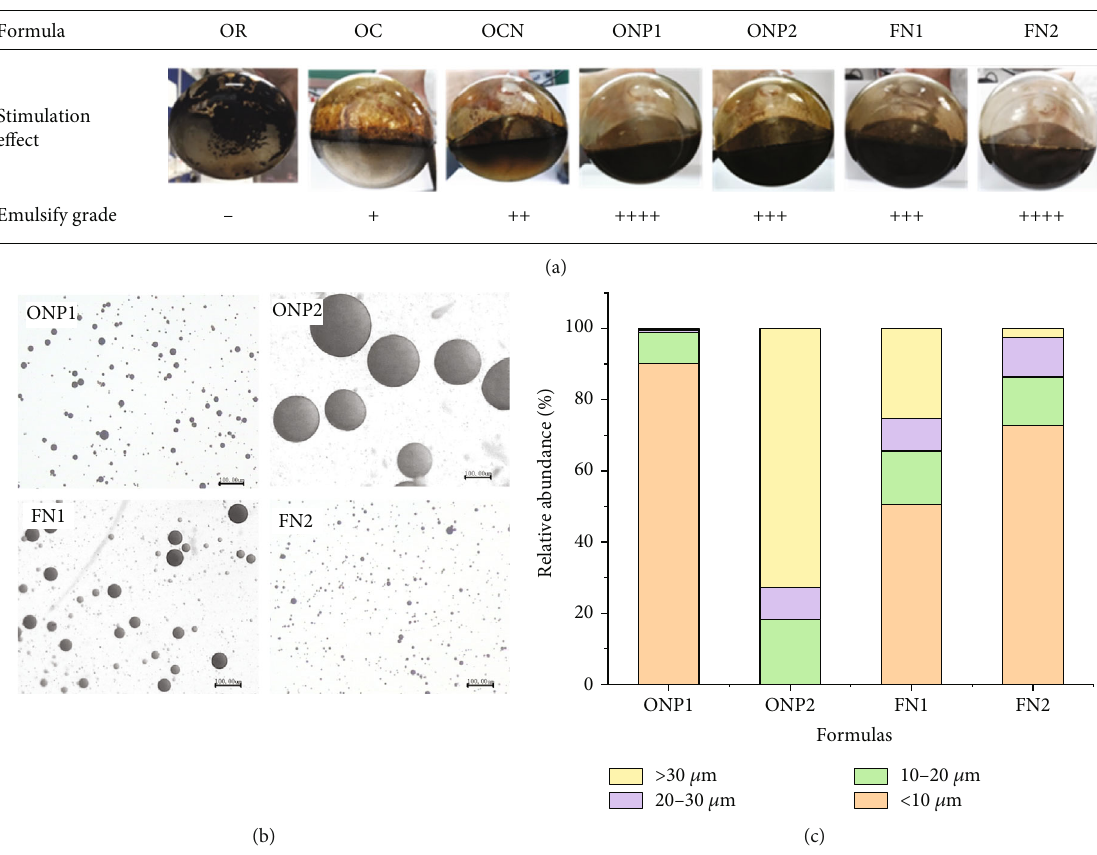
Figure 2: Emulsi fi cation e ff ects of the stimulated formation water with crude oil: (a) emulsify grade determination of six formulas and the original formation water sample; (b) microscopic images of emulsi fi ed crude oil; (c) droplet size distribution of crude oil